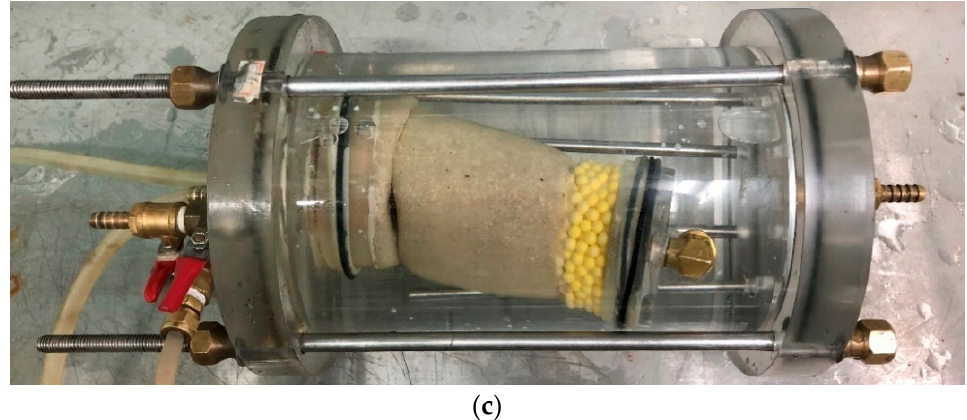
Figure 4. Progression of internal erosion failure with the particle size of 0.725 mm, confining pressure of 50 kPa, and seepage exit opening of 1 cm: ( a ) specimen under saturation; ( b ) initiation of internal erosion failure with a sinkhole; ( c ) sand particles greatly eroded away at the downstream end.